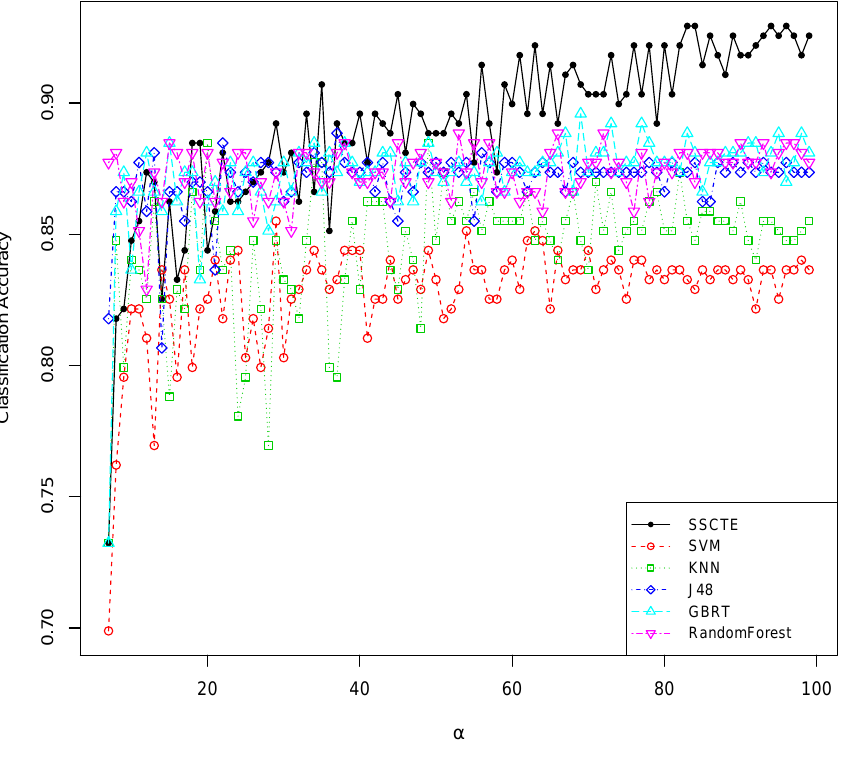
Figure 8. SSCTE’s performance in terms of ACC.